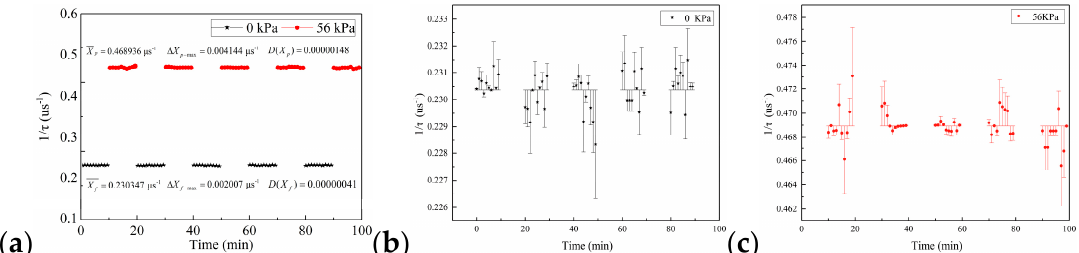
Figure 13. Repeatability test results of pressure sensor on the bottom; ( a ) the ring-down time curve when 56 kPa is loaded and not loaded on the sensor; ( b ) the error bar of 1 / τ response when 56 kPa is not loaded on the sensor; ( c ) the error bar of 1 / τ response when 56 kPa is loaded on the sensor.